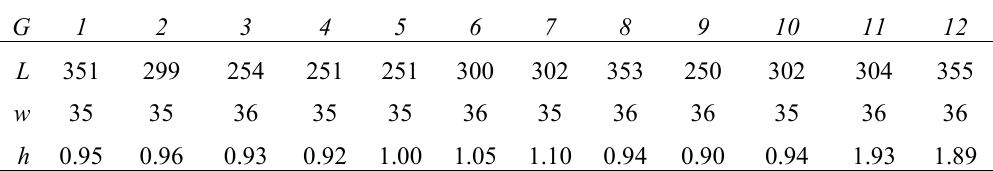
Table 1. The geometry of the 12 cantilevers tested in this work. The geometrical dimensions are in micrometers.